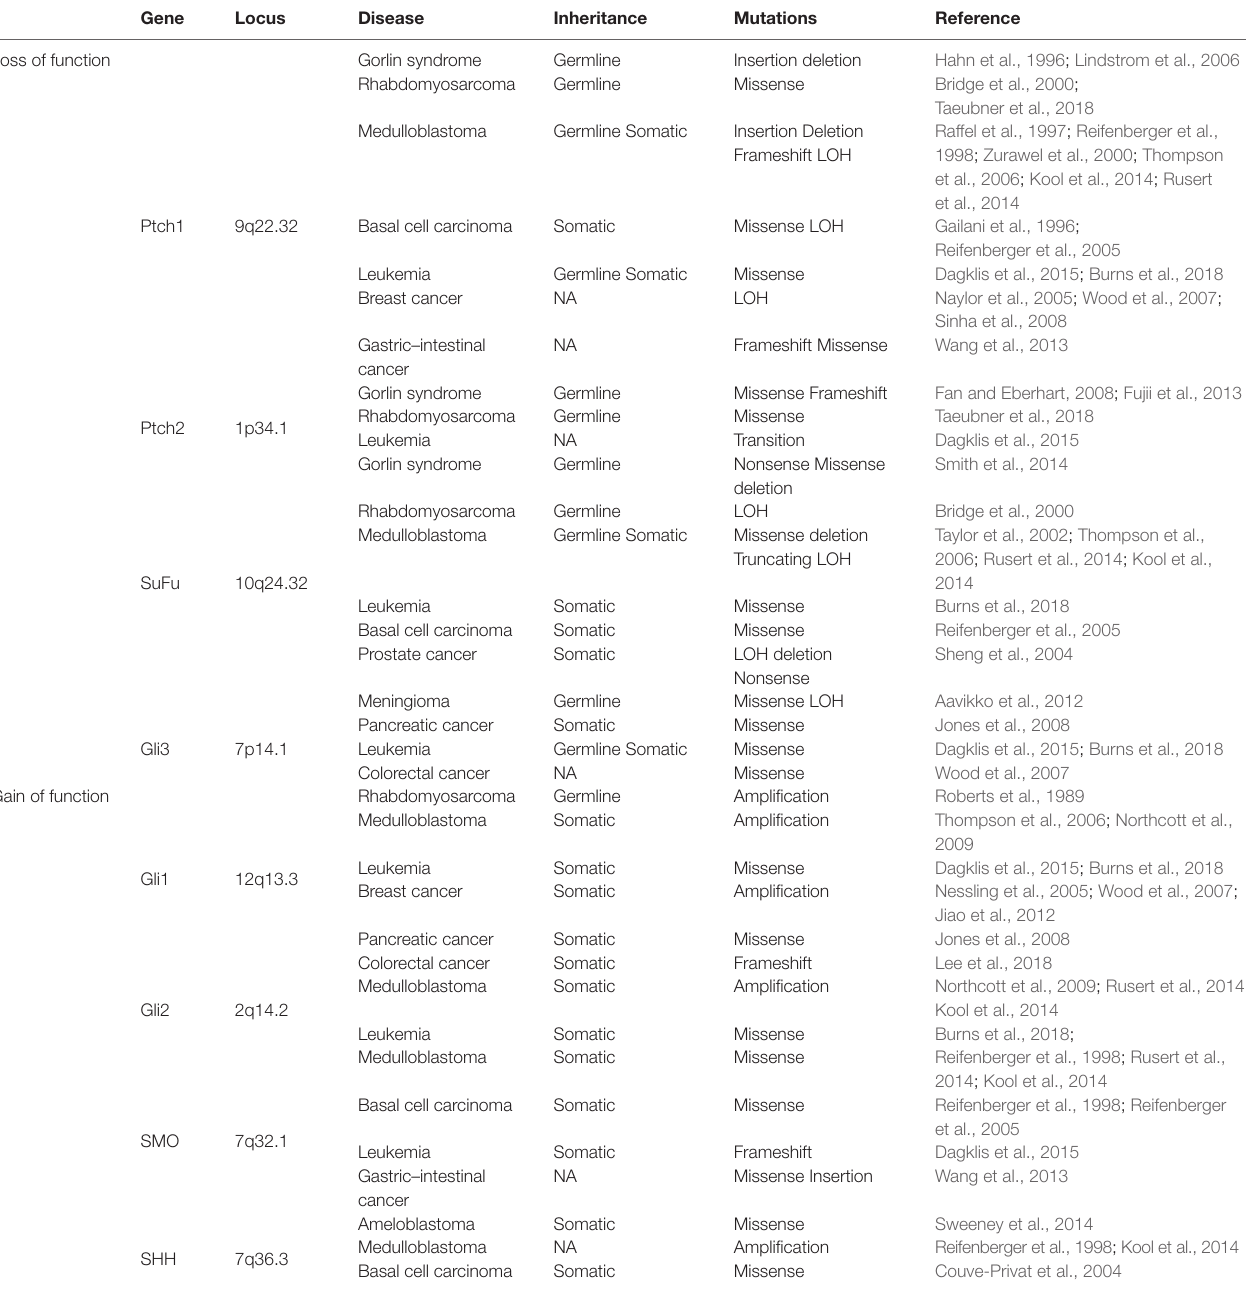
TABLE 1 | Mutations of HH signaling Gene Locus Disease Inheritance Mutations